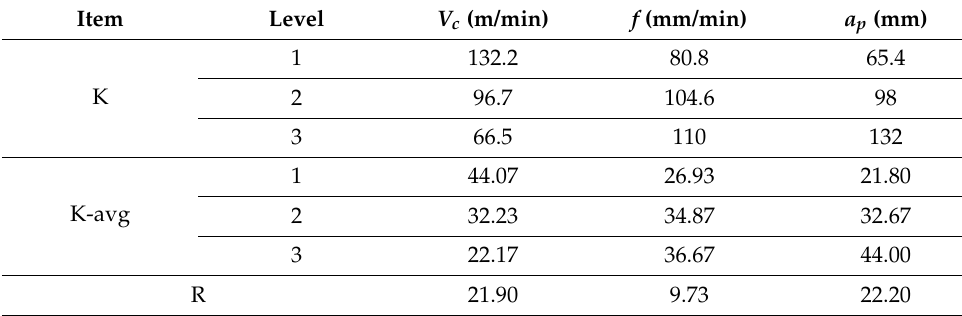
Table 10. Range analysis of the tangential milling force F t .